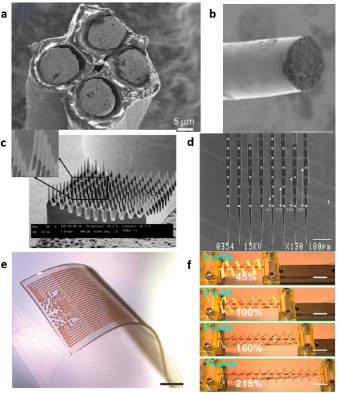
Figure 1. Types of neural electrode: ( a ) tetrode [23], ( b )single wire [24], ( c ) Utah electrode [25], ( d ) Michigan electrode [26], ( e ) high-density stretchable electrode grids for chronic neural recording [27] , and ( f ) kirigami [28] .